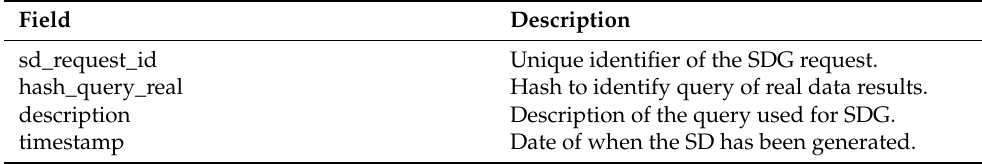
Table 1. Information fields of the downloaded SD.